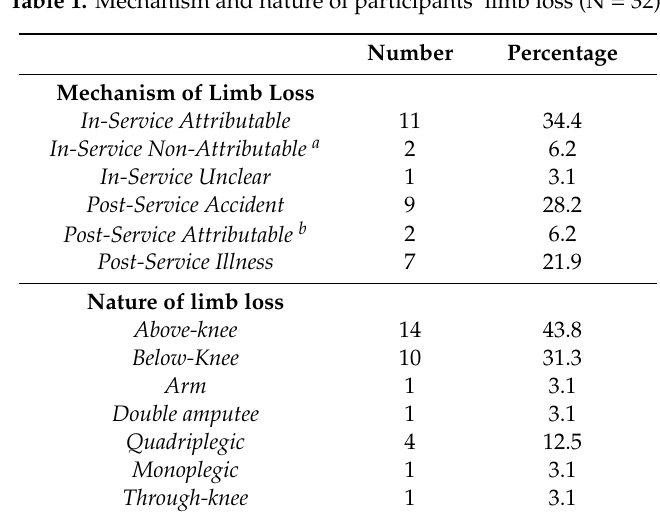
Table 1. Mechanism and nature of participants’ limb loss (N =